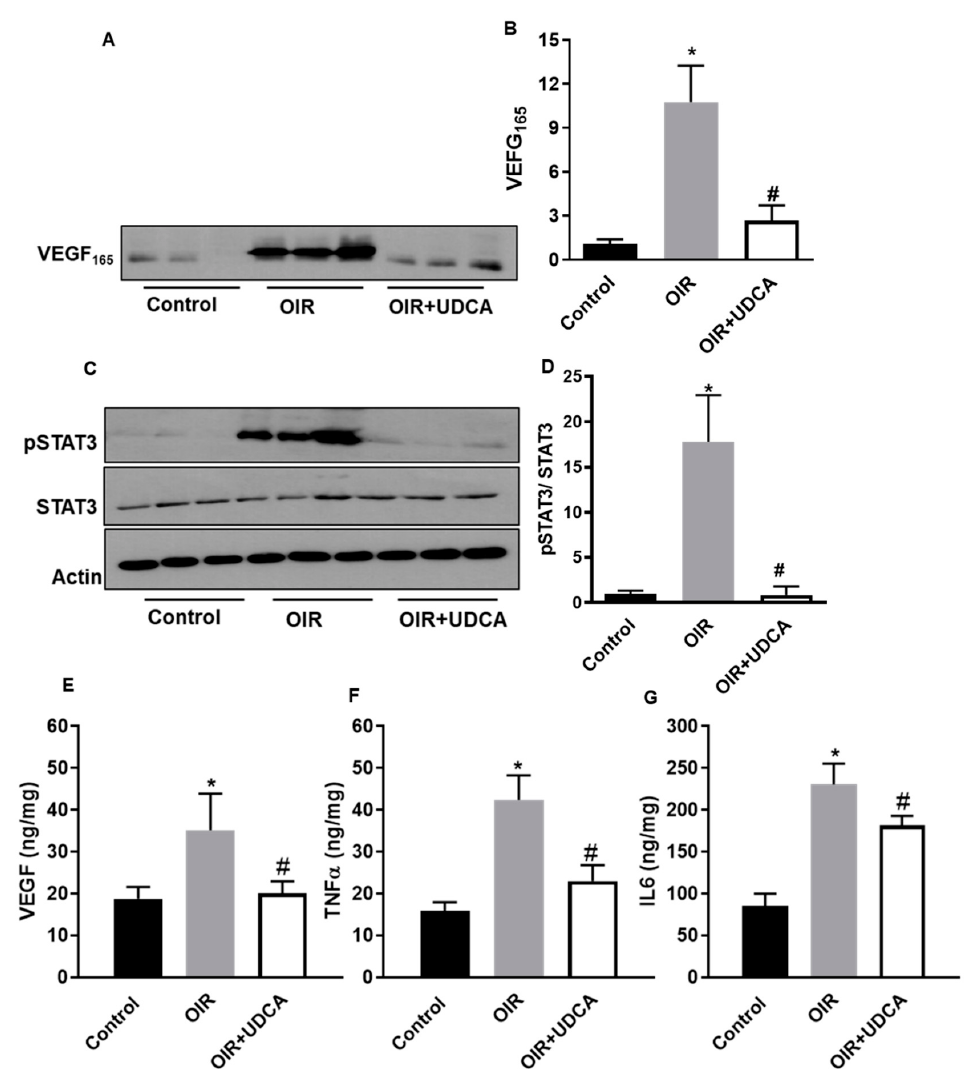
Figure 7. UDCA regulates STAT3 (Signal transducer and activator of transcription 3) signaling to reduce inflammation in OIR mice. Total protein fractions from control mice (room air), OIR mice, and OIR mice treated with 50 mg / kg UDCA (P7–P17) at P17 were used to analyze protein levels of VEGF 165 ( A ), pSTAT3, and STAT3 ( C ) by Western blotting. ( B – D ) Densitometry graphs showing changes in protein expressions. ( E – G ) The total retinal extracts were used to quantify protein levels of vascular endothelial growth factor (VEGF), tumor necrosis factor α (TNF α ), and interleukin 6 (IL-6) using ELISA assay. Values are mean ± S.D ( n = 6 retinas per group). * p < 0.05 vs. control and # p < 0.05 vs. OIR.